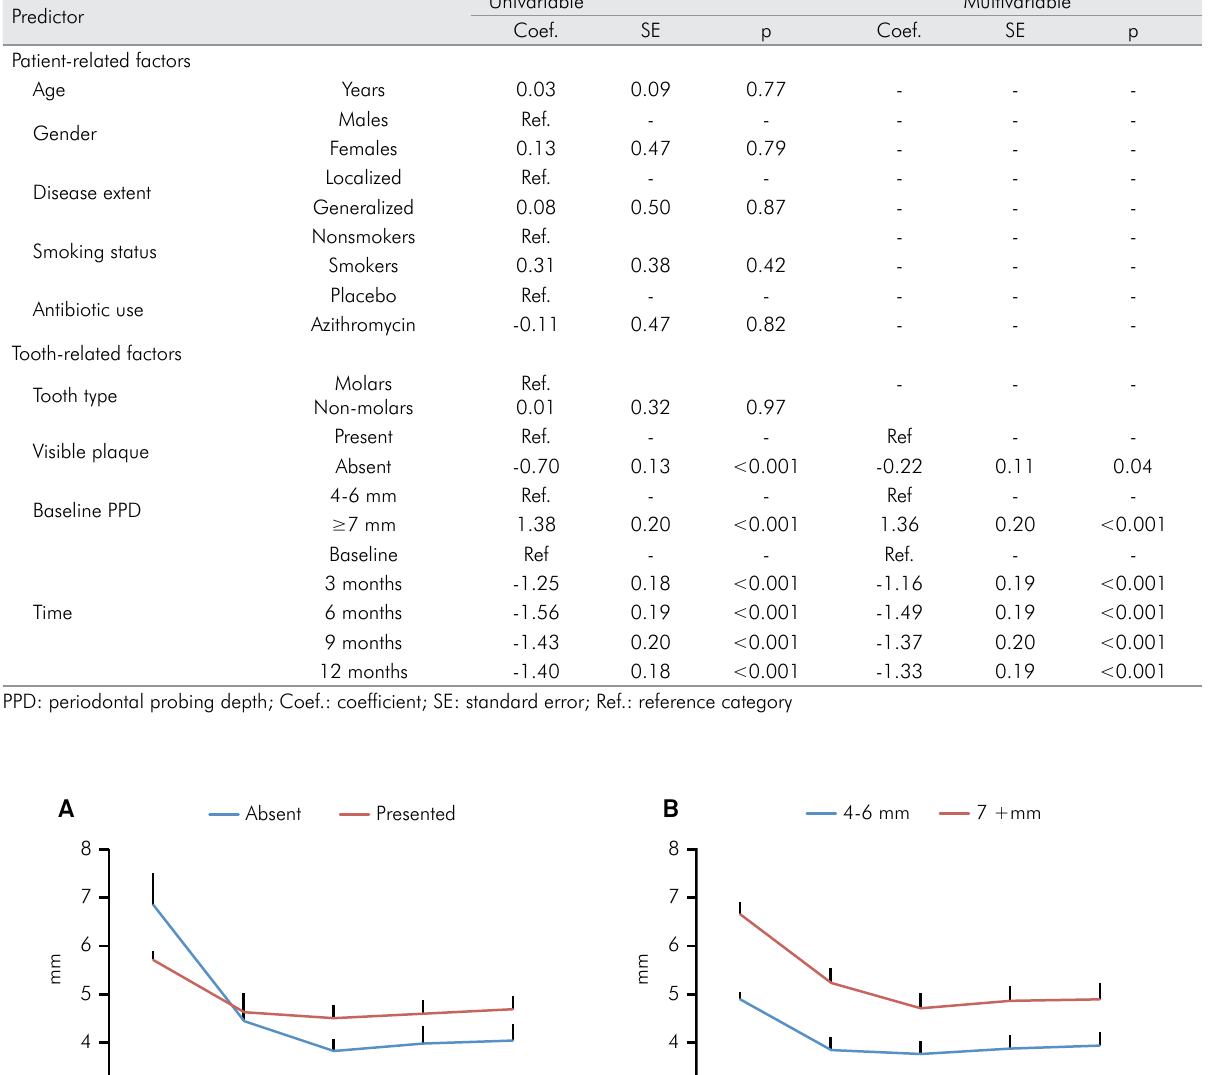
Table 3. Univariable and multivariable prediction models of CA level change over 12 months. Predictor